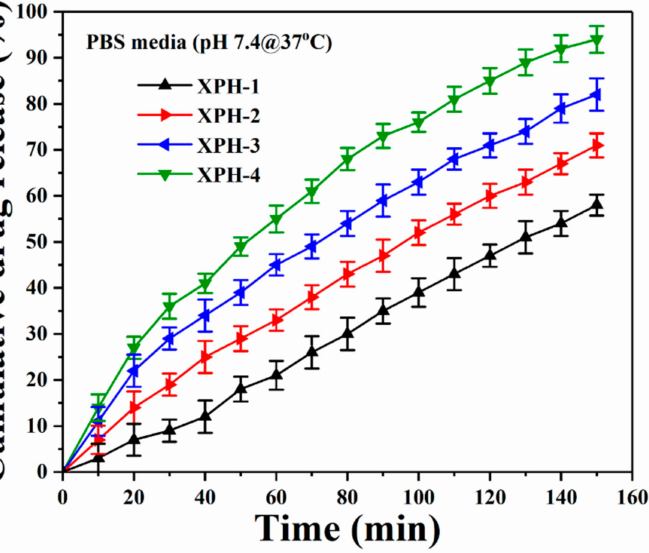
Figure 6. The drug release profile of all polymeric hybrid nanocomposite scaffolds in PBS solution at 37 ◦